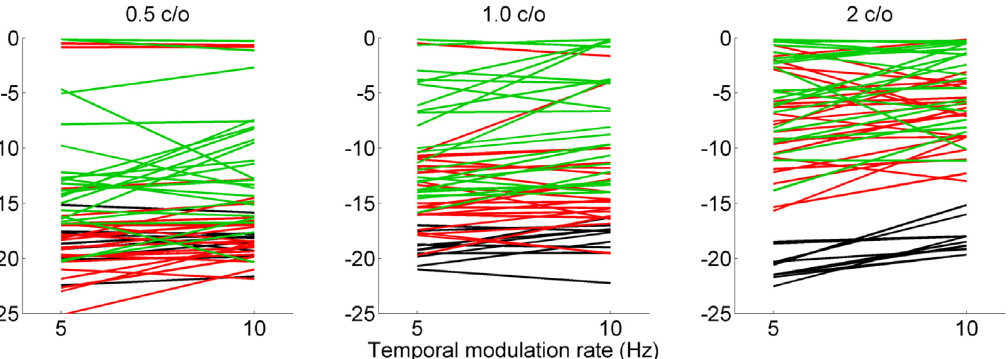
Fig 3. STM detection thresholds for individual subjects, shown as a function of temporal rate. Results for spectral rates of 0.5, 1.0, and 2.0 c/o are shown in the left, middle, and right column, respectively. The black, red, and green lines represent the STM detection thresholds for normal-hearing, hearing- impaired, and cochlear implant subjects, respectively.